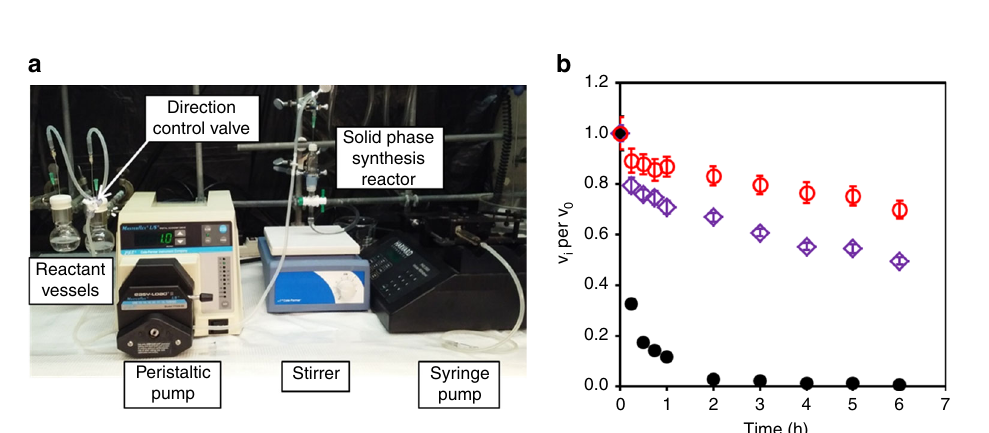
Fig. 4 Automated one-pot rapid PARIS protein – polymer conjugate synthesis and properties. a The experimental setup of a fl ow reactor for PARIS. b Irreversible inactivation of native CT and CT-pCBMA at 50 °C. CT-pCBMA synthesized in the fl ow reactor immobilized at pH 6.0 (red open circle) or pH 8.0 (purple open diamond) and native CT (black closed circle) were incubated in 100 mM sodium phosphate buffer (pH 8.0, 50 °C) at 3.9 μ M CT for 6 h. Both CT-pCBMA conjugates showed enhanced thermostability compared to native CT and CT-pCBMA immobilized at pH 6.0 with a free N -terminus showed the highest thermostability similar to batch mode studies. Error bars represent standard deviation from triplicate measurements